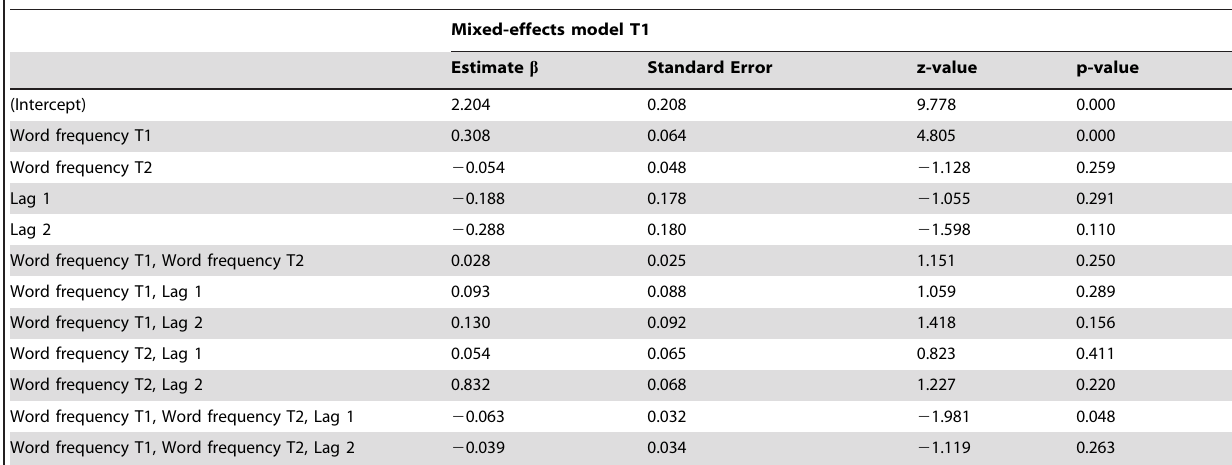
Table 1. The estimates and z-values of the mixed-effects model for T1 accuracy.